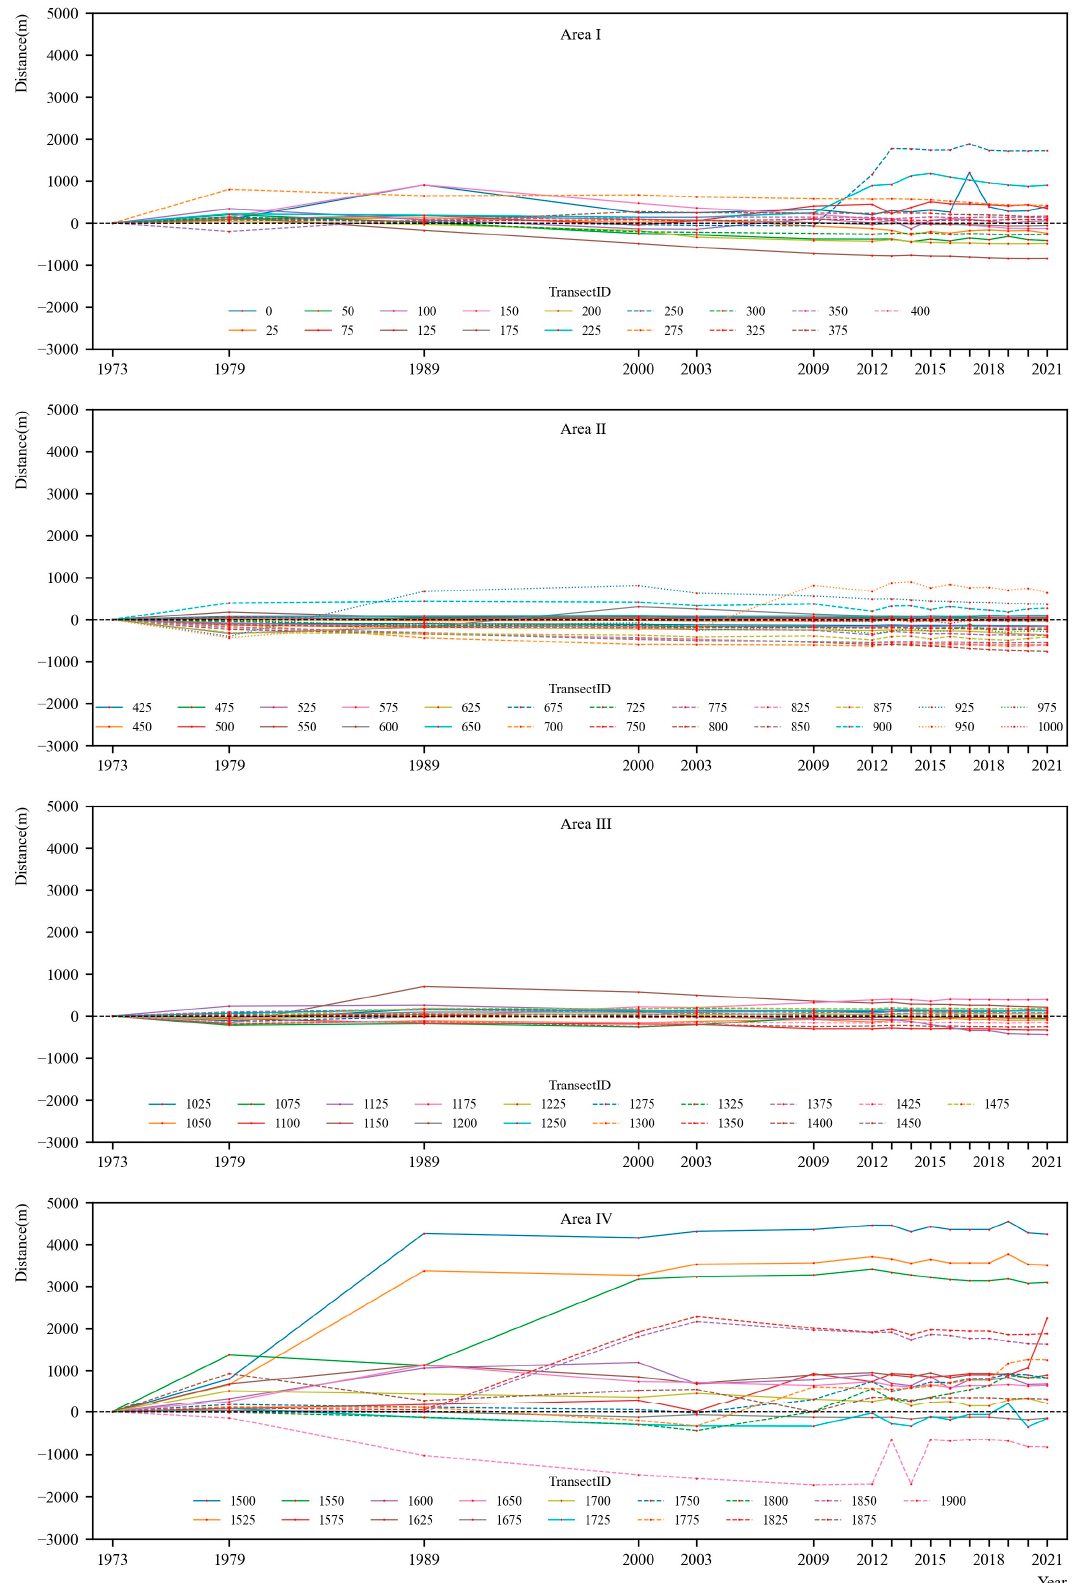
Figure 5. Time series change in characteristic transects length along the coastline. Characteristic transects were defined as one per 25 transects selected from among 1917 transects to describe the spatial and temporal evolution of the coastline.